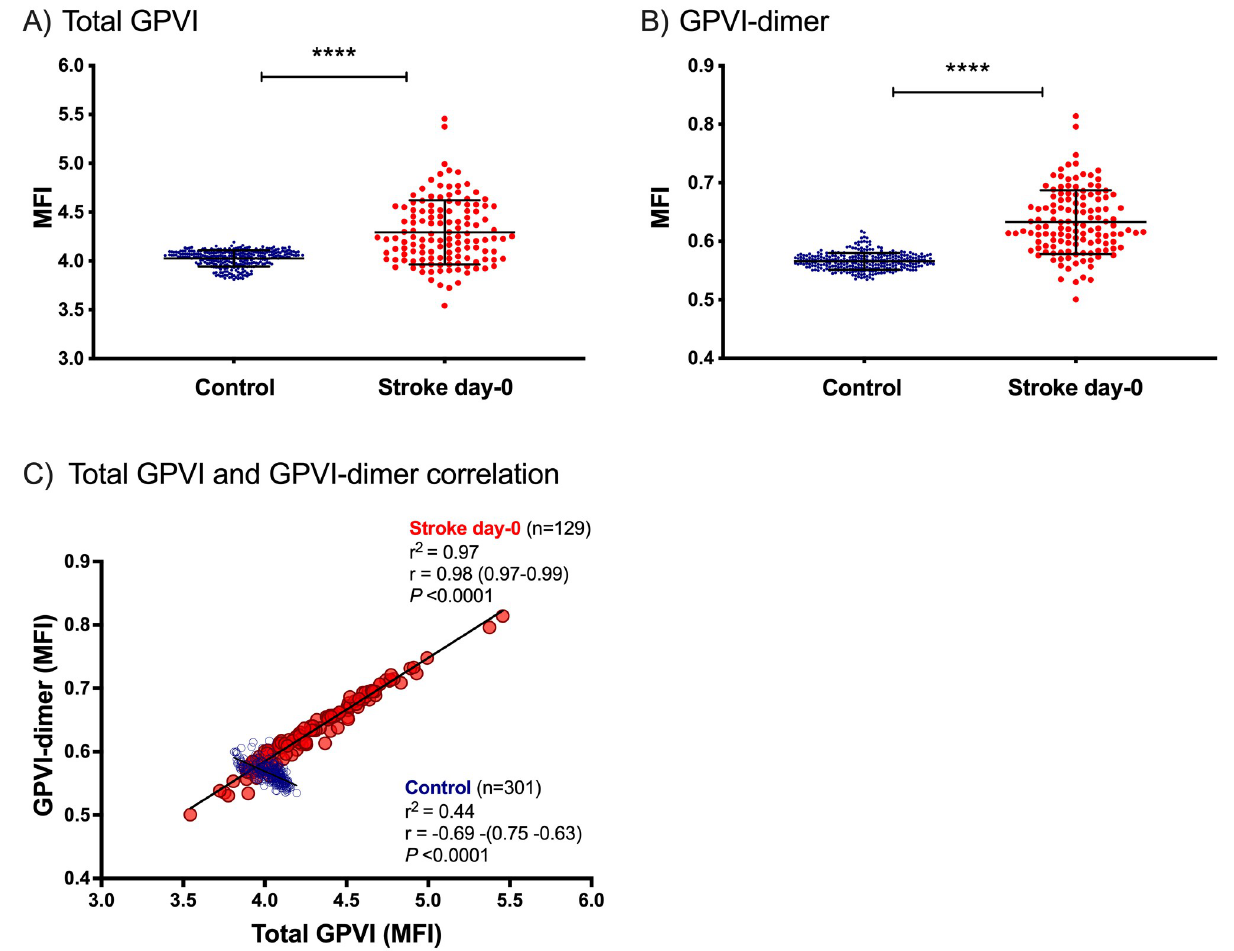
Fig 1. Comparison of GPVI expression between control and stroke cohorts and GPVI-dimer as a function of total GPVI in control and stroke cohorts. A) Total GPVI and B) GPVI-dimer are both significantly higher in the stroke population at admission compared to the control cohort ( P < 0.0001). P -values were calculated using an unpaired t-test and the error bars represent the mean MFI of each of the cohorts ± SD. C) Correlation between platelet surface total GPVI-dimer and GPVI-dimer. These data were calculated using Pearson correlation coefficient and the regression line is presented for each set of data. The control platelets show a narrow range of GPVI-dimer levels, which is negatively correlated to total GPVI ( P < 0.0001). In contrast, the surface GPVI-dimer of stroke patients’ platelets demonstrate strong positive correlation to the amount of total GPVI ( P < 0.0001) and in general have higher GPVI-dimer levels than the controls. MFI = mean fluorescence